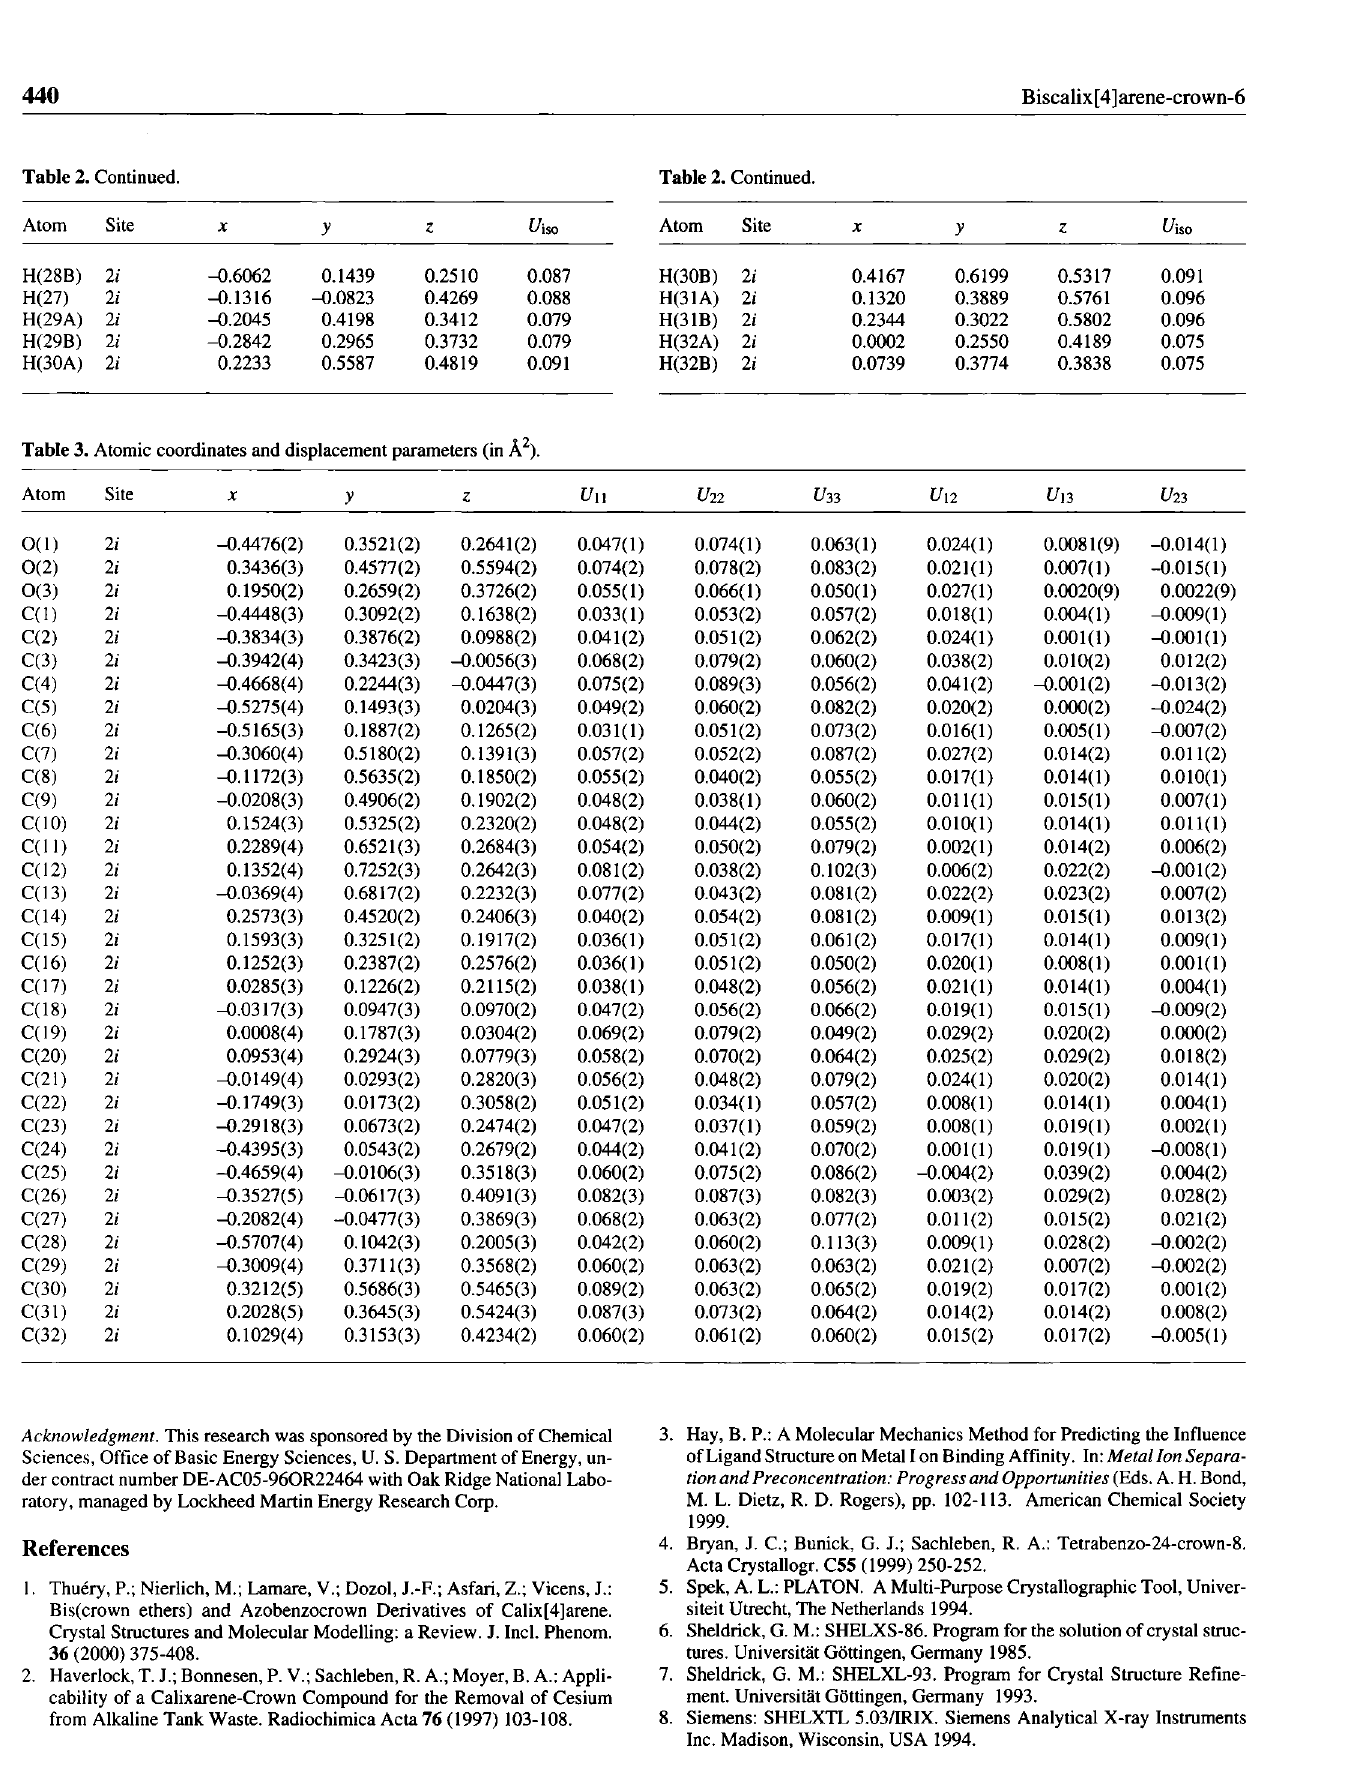
Table 3. Atomic coordinates and displacement parameters (in A 2